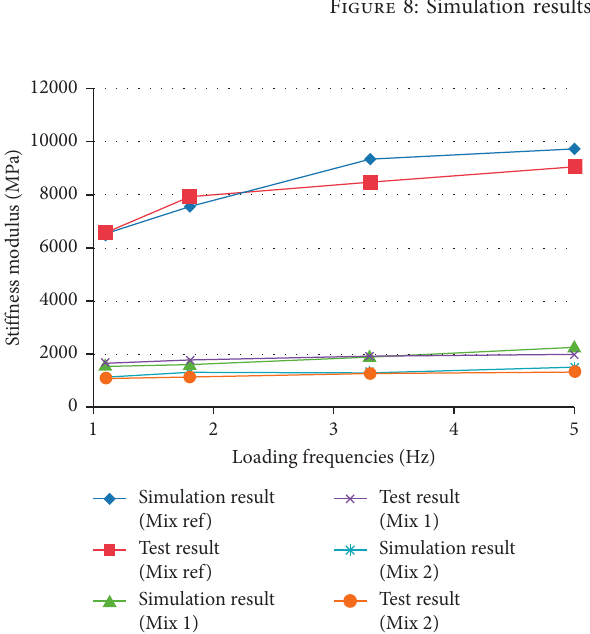
Figure 9: Comparisons between the simulation results and test results.